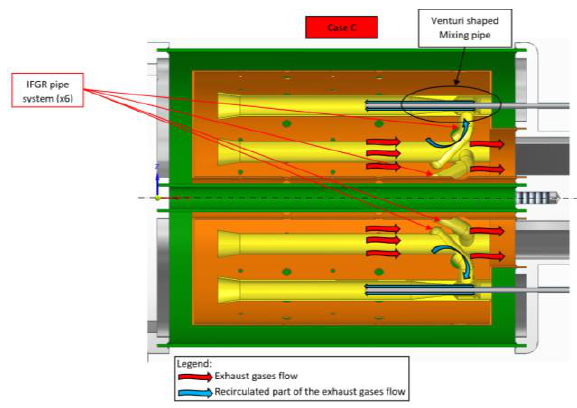
Fig. 5. Modified combustor (Case C)